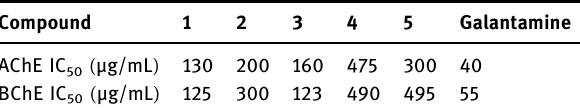
Table 4: Percent alpha - amylase and alpha - glucosidase inhibition by the synthesized compounds Compound